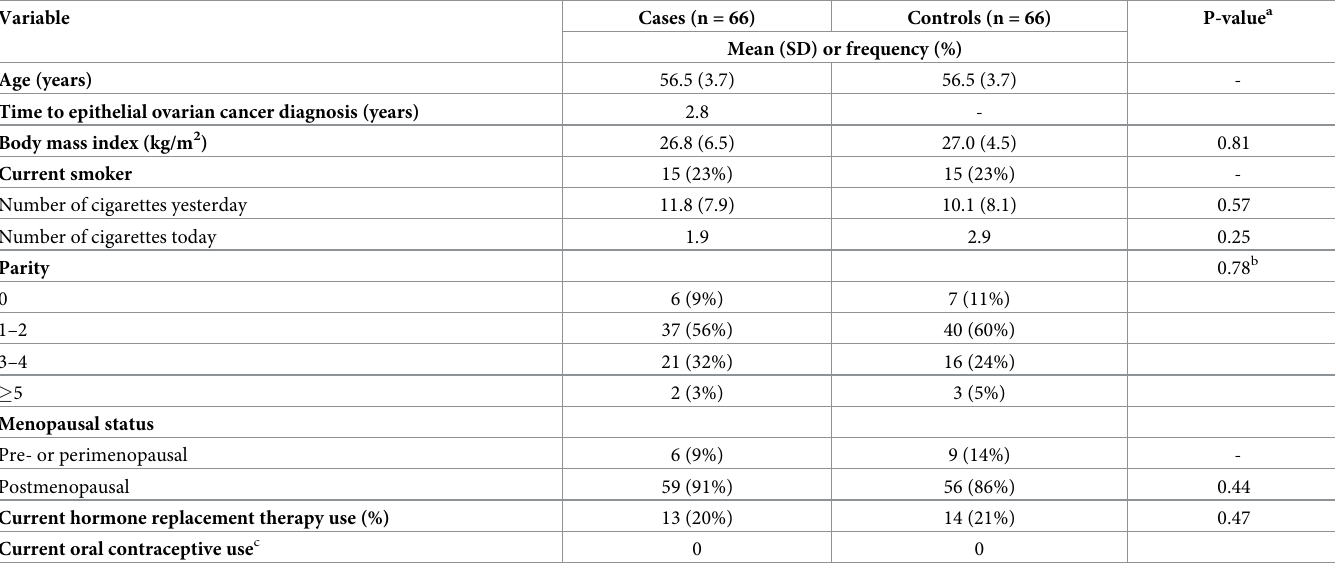
Table 1. Participant characteristics on day of blood sample collection.